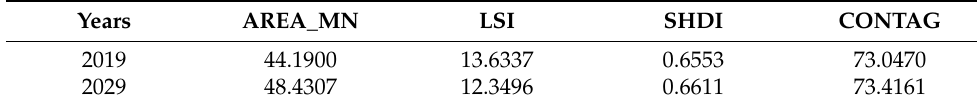
Figure 6. Prediction map of the spatial distribution pattern of landscape types in 2029. Table 5. Trend of landscape level index change during 2019–2029. Years